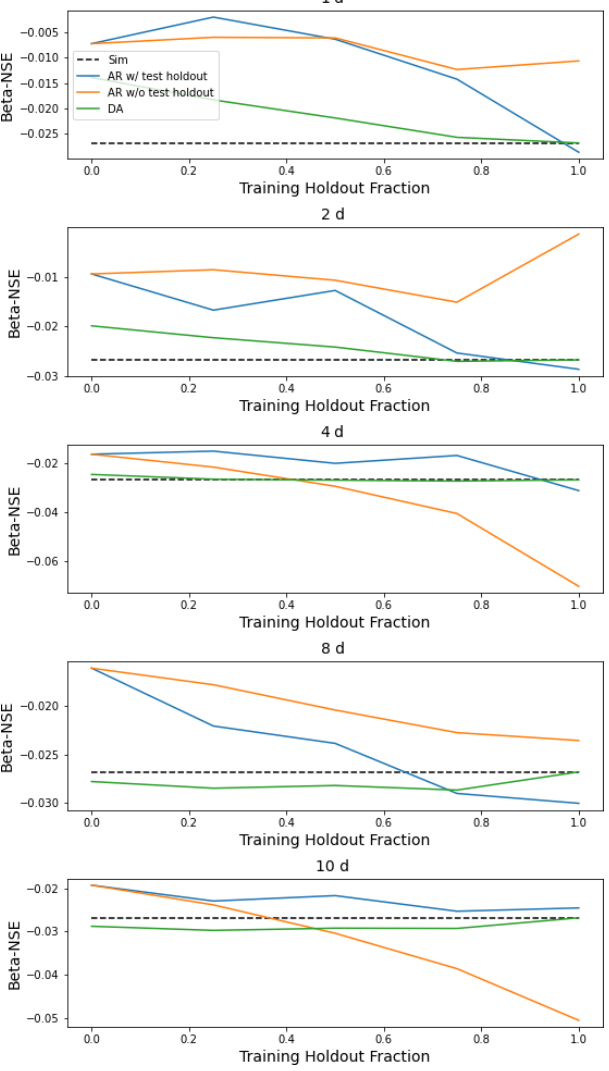
Figure H3. Same as Fig. 4 but for α -NSE, which is the ratio of the standard deviation of the observed vs. modeled hydrographs.